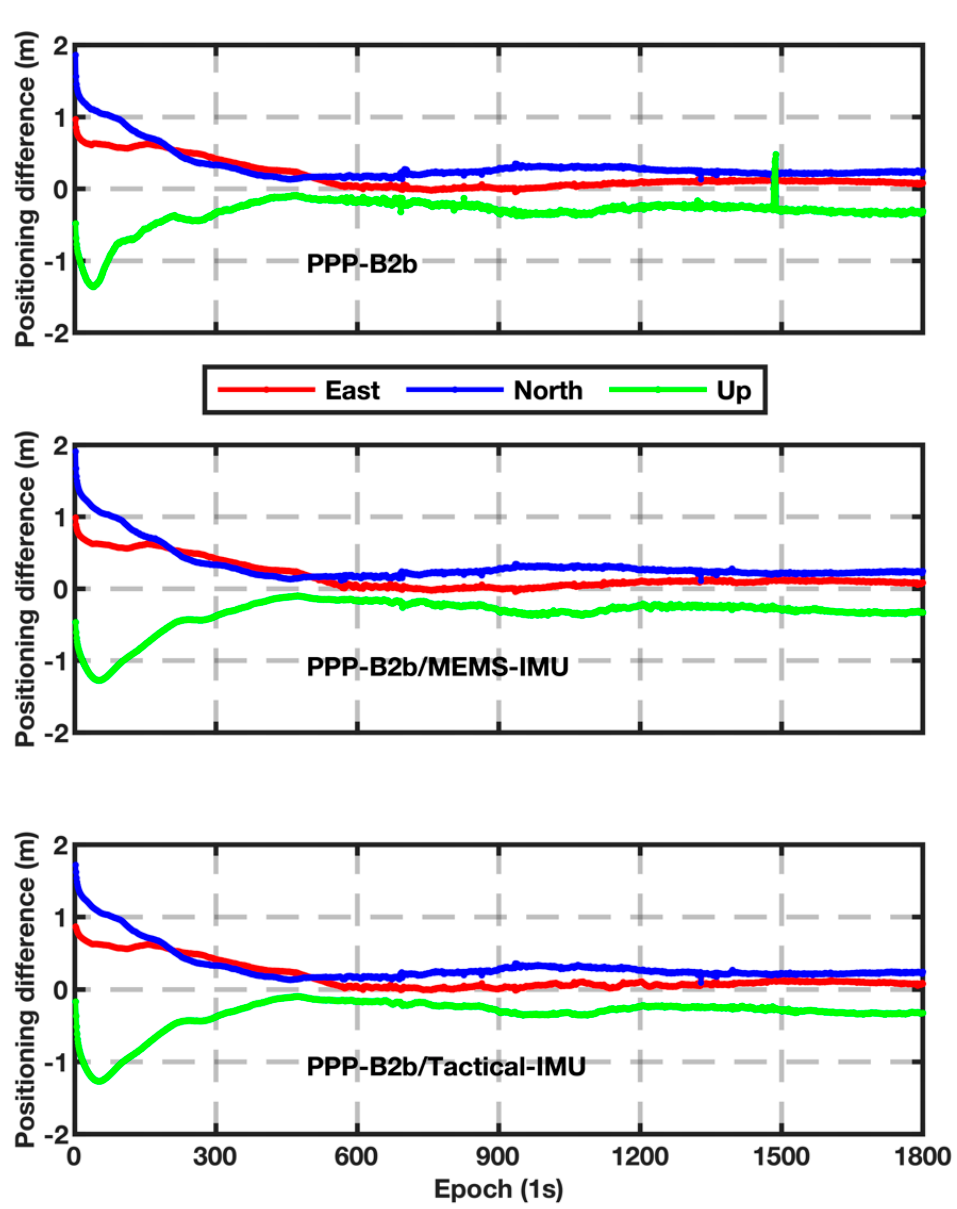
Figure 4. Positioning errors of PPP-B2b only ( top panel), PPP-B2b/MEMS-IMU loosely coupled integration ( middle panel), and PPP-B2b/tactical − IMU loosely coupled integration ( bottom panel), for Experiment A. Table 3. Statistics of the positioning errors (unit: cm).